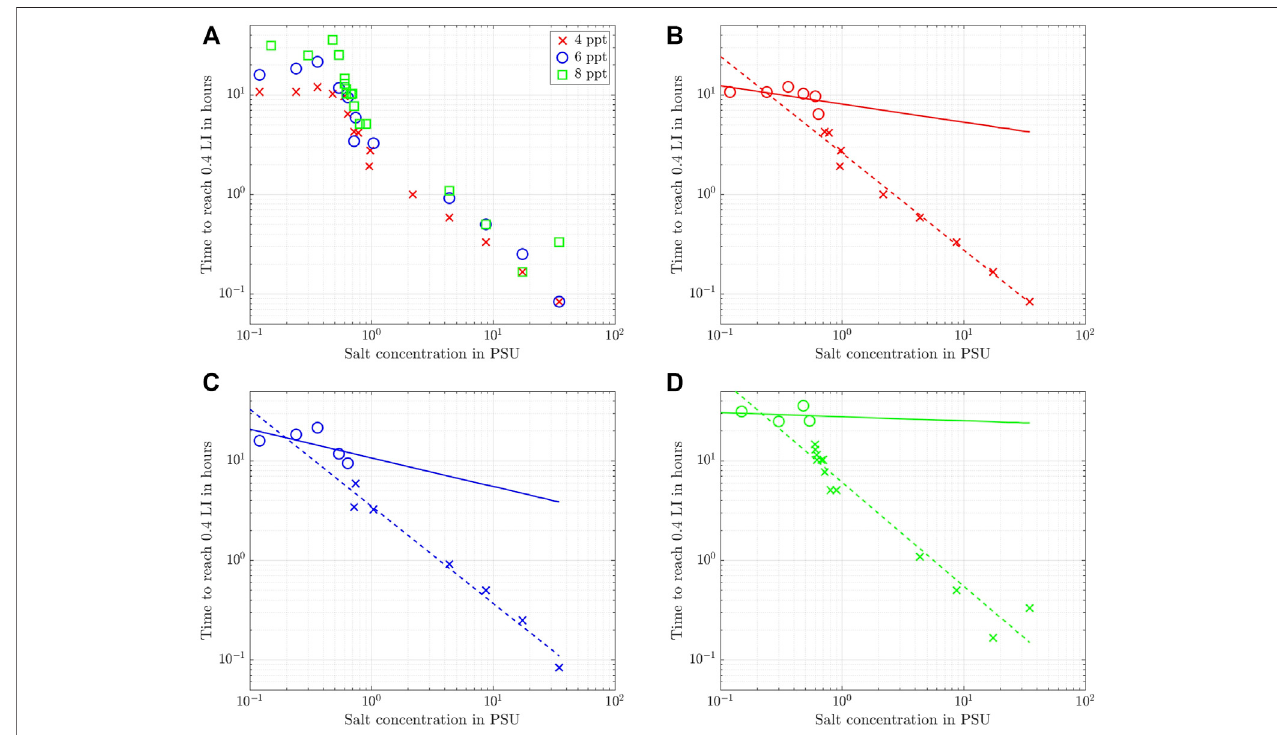
FIGURE7| Time required forthe normalized lightintensity toclear upto0.4. (A) Forall three batches forcomparison, (B) 4 ppt, (C) 6 ppt, and (D) 8 ppt.The solid and dashed lines represent power law fi ts to the circles and crosses, respectively.